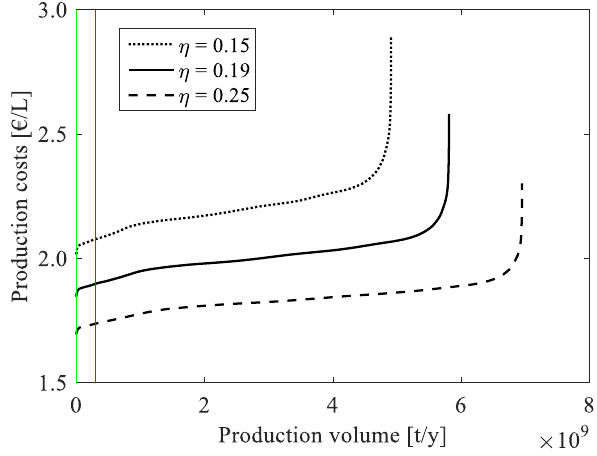
Figure A3. The cost-supply curve of solar thermochemical jet fuel for Australia with current national jet fuel demand [94] ( green line ) and world jet fuel demand [92] ( red line ).